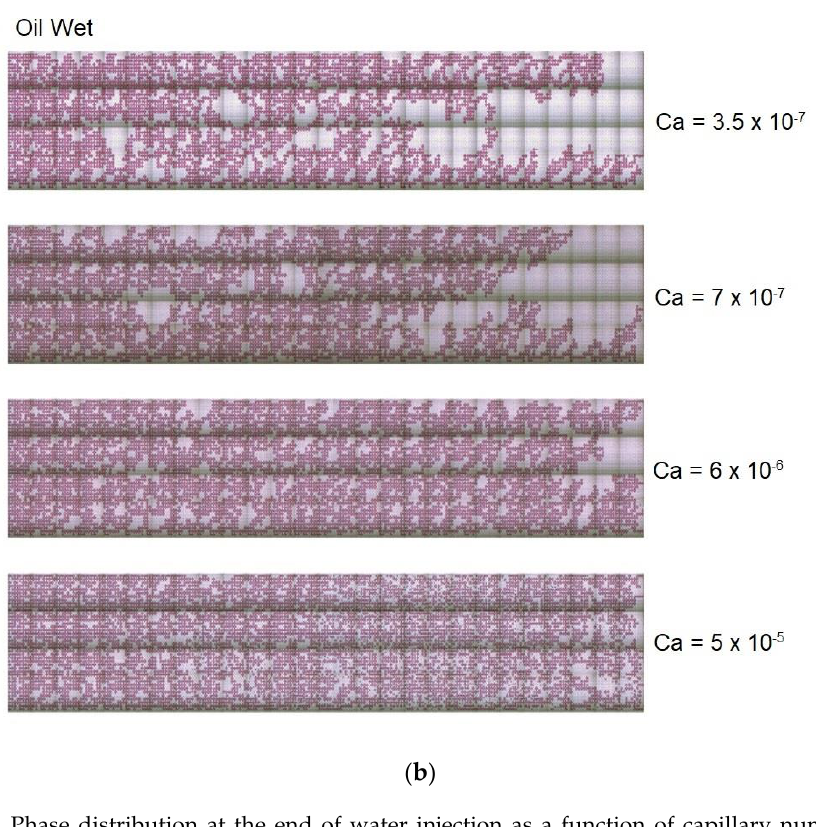
Figure 7. Phase distribution at the end of water injection as a function of capillary number: ( a ) water-wet and ( b ) oil-wet micromodels. Energies 2018 , 11 , x